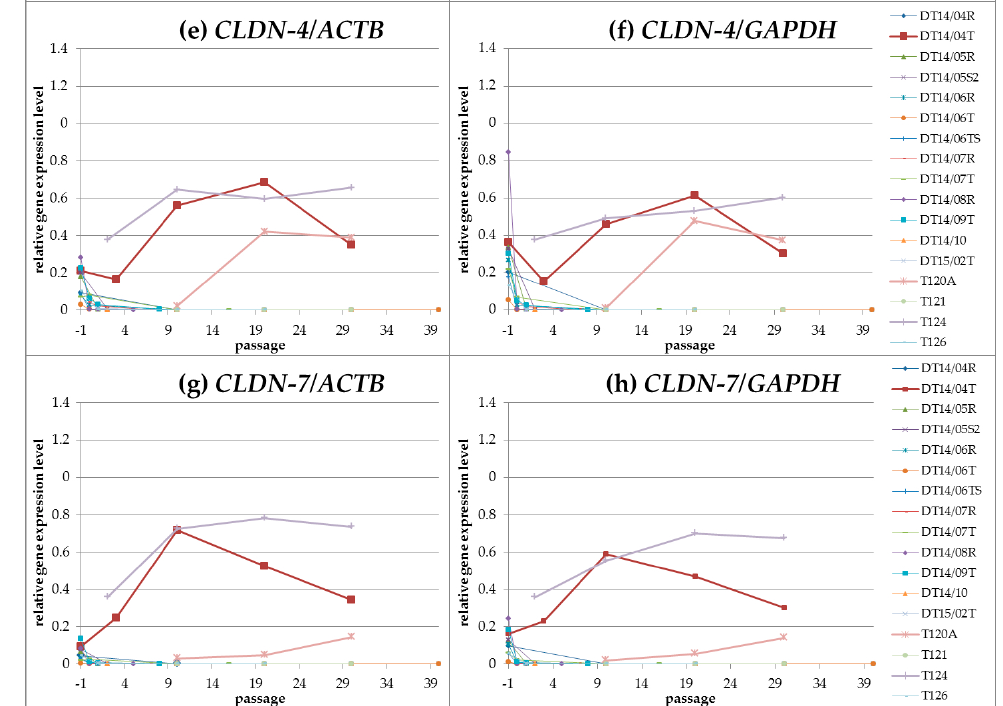
Figure 2. CLDN gene expression profiles of canine mammary non-neoplastic and neoplastic tissue derived cell cultures during cultivation until passage 30: Cell lines T120A, T124, DT14/04T and DT14/10 exhibited high CLDN-1 ( a , b ) gene expressions; in the other cell cultures the expression was below 0.1 ( CLDN-1 relative to ACTB and GAPDH respectively: T120A: 0.58, 0.56; T124: 0.61,